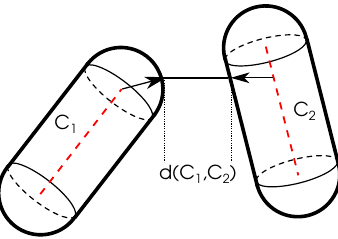
Figure 4. Collision avoidance with rounded caps. The distance between the two is calculated as d .